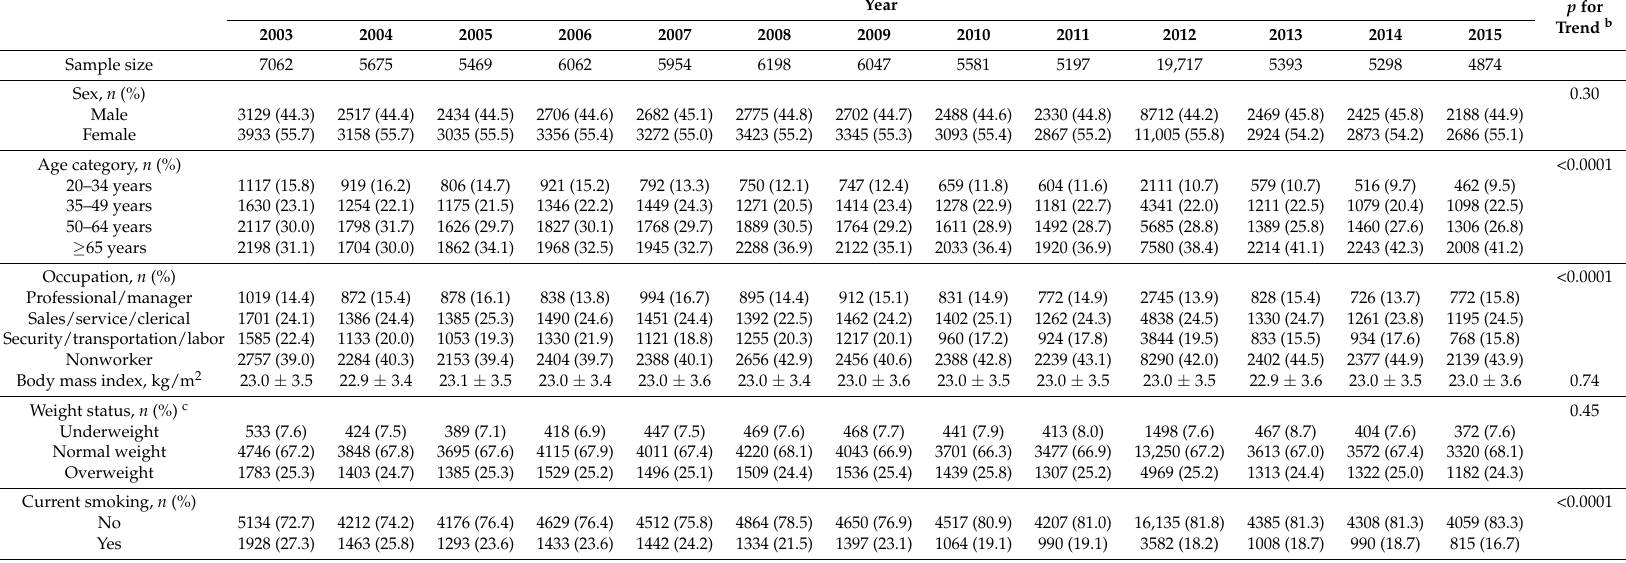
Table 1. Characteristics of the 88,527 participants of the National Health and Nutrition Survey, Japan 2003–2015 a